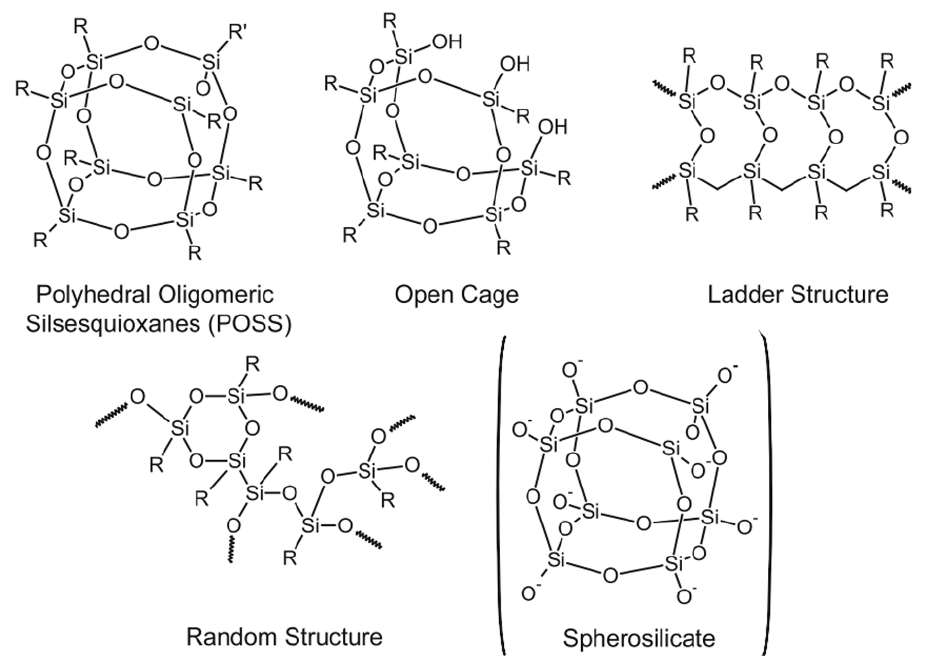
Figure 17. The structures of some silsesquioxanes. Reprinted with permission from [9]. Copyright Springer Nature, 2003. Polymers 2019 , 11 FOR PEER REVIEW